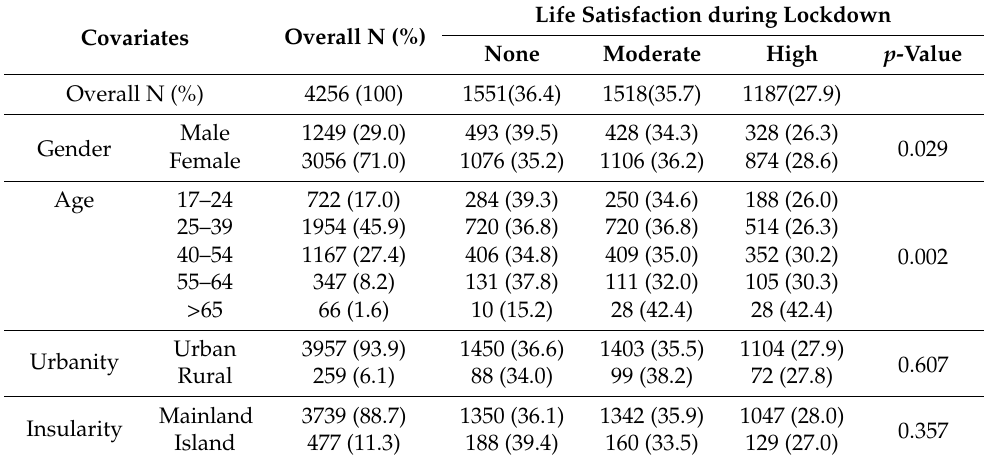
Table 1. Descriptive statistics of categorical variables.